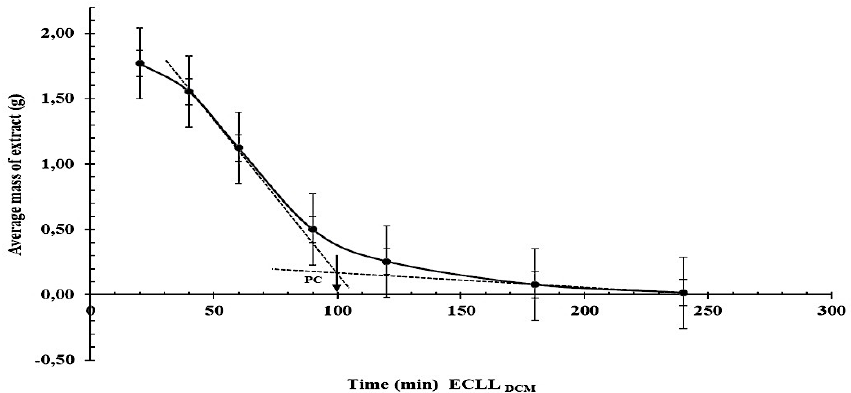
Figure 3. Average mass of solvent-free extracts obtained in relation to the time of process during the CLLE DCM of WW.